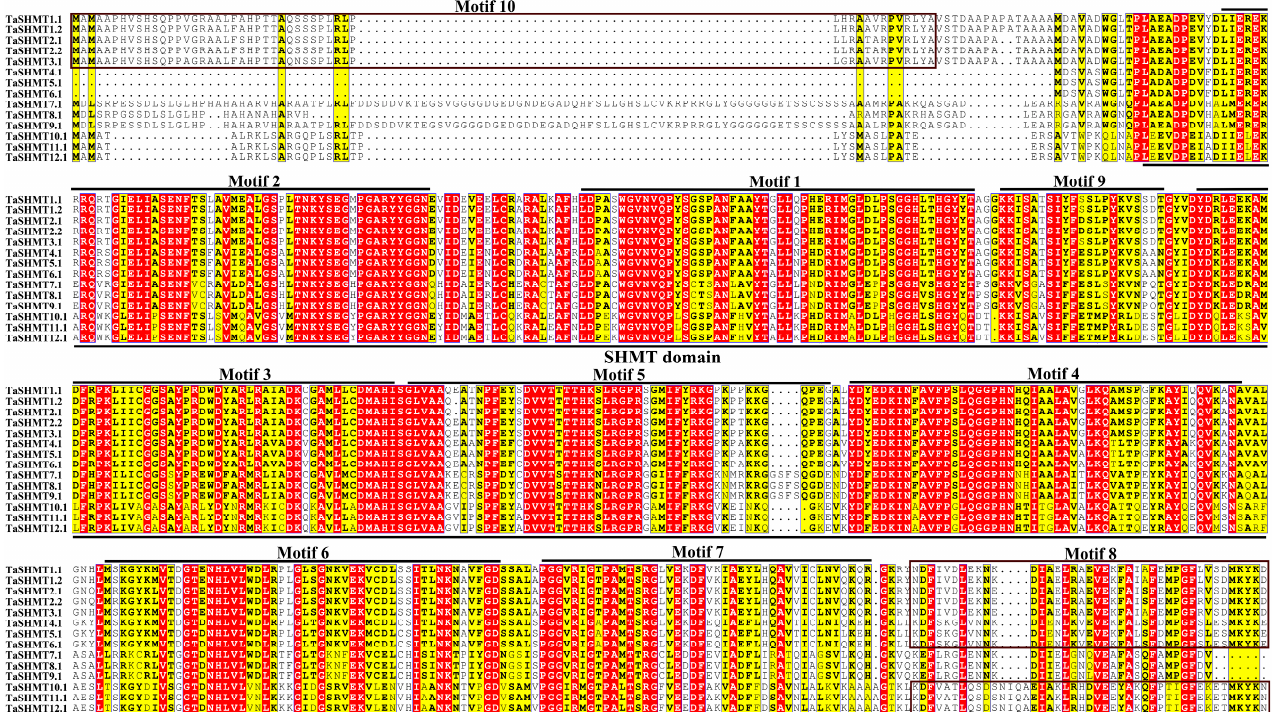
Figure 5. Multiple sequence alignment of the conserved domains of TaSHMT gene family in wheat. SHMT domain and moitf1-10 are